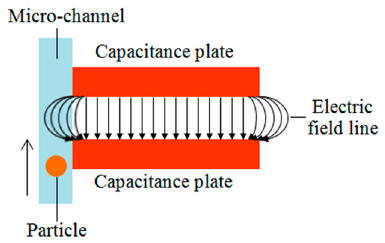
Figure 4. Electric field distribution of parallel plate capacitor.